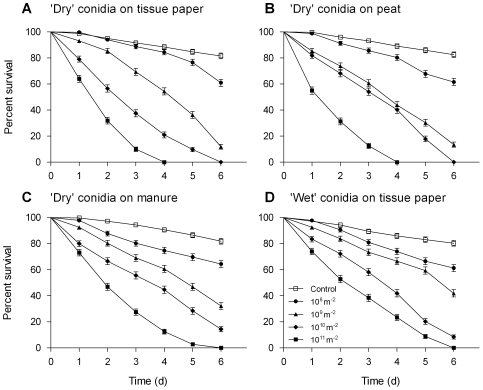
Influence of substrates.Survival curves (Mean±SEM) for adult Culiocides nubeculosus exposed for 6 days to different doses (108–1011 conidia m−2) of ‘dry’ and ‘wet’ conidia of Metarhizium anisopliae V275 on separate substrates at 20±1°C. Controls were not exposed to any fungus (‘0’ dose). Data represent survival of eight replicates of approximately 40 adult males and females/replicate.